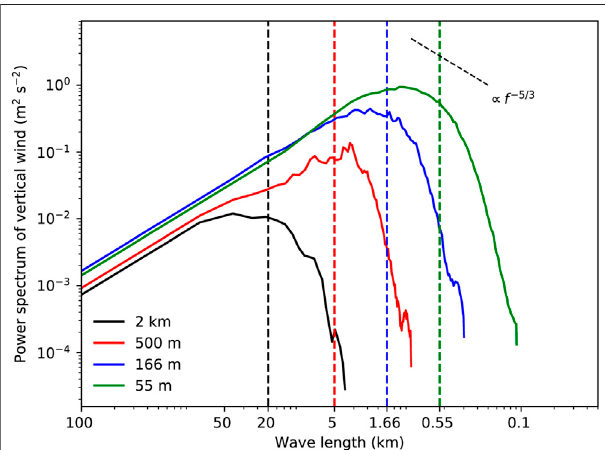
FIGURE14| Energyspectra(sold)verticalvelocity(m 2 s − 2 )atthe183-m height at t (cid:2) 9 h of the simulation in the radius of the 41.25 km from the storm center (namely in the d06 domain) from the grid spacings of 2 km, 500 m, 166 m, and 55 m, respectively. The vertical dash lines indicate the corresponding 10 times of the grid spacings.